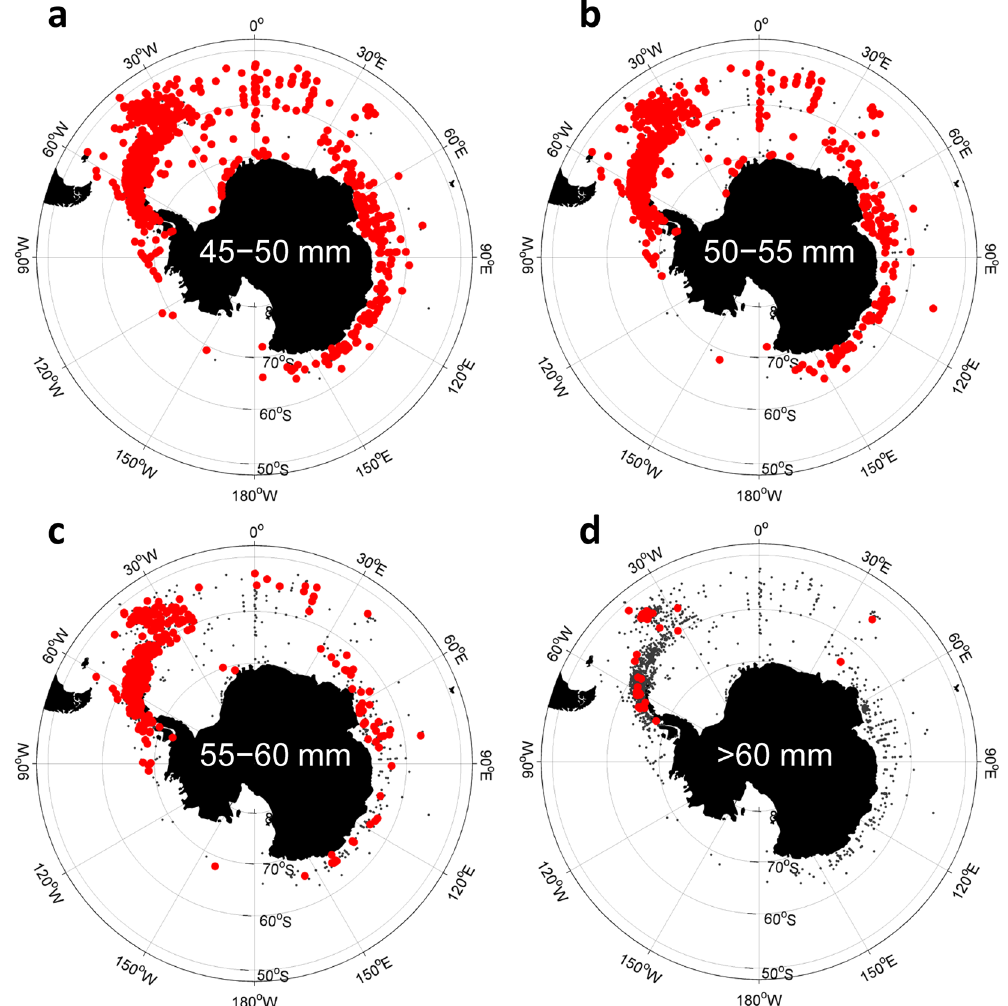
Figure 7. Distribution of krill in different size ranges recorded in net samples: ( a ) 45 to 50 mm, ( b ) 50 to 55 mm, ( c ) 55 to 60 mm and ( d ) > 60 mm. Red dots show presence, grey dots absence of each krill size from net samples. Data from KRLLBASE 69 . Figure created with Matlab software version R2013a (www.mathworks.com) using M_Map mapping toolbox version 1.4f